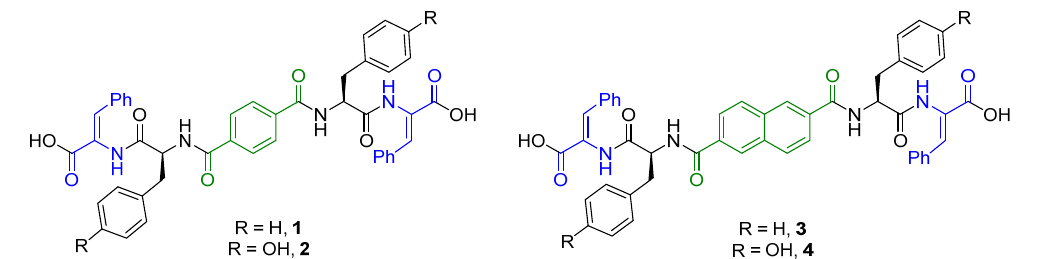
Figure 2. Chemical structures of the studied dehydrodipeptide derivatives 1 , 2 , 3 and 4 .